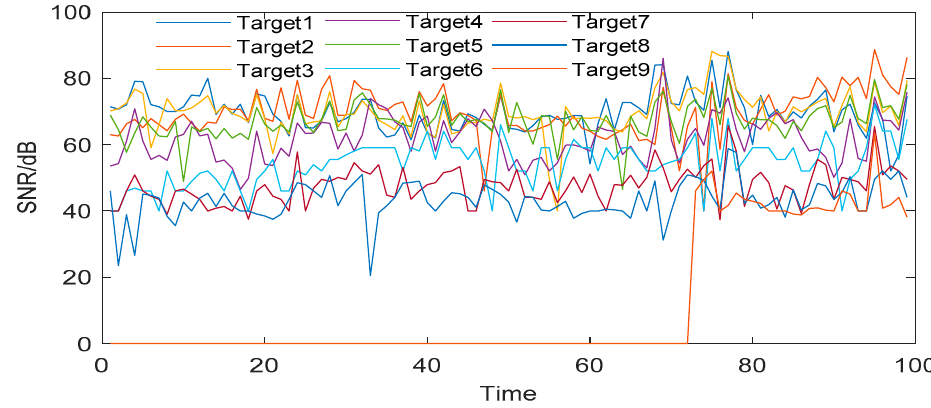
Figure 10. SNR of targets before image preprocessing.